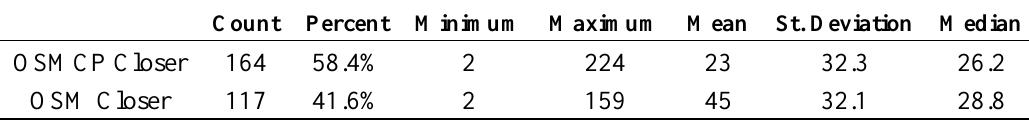
Table 8. Accuracy comparison for matched